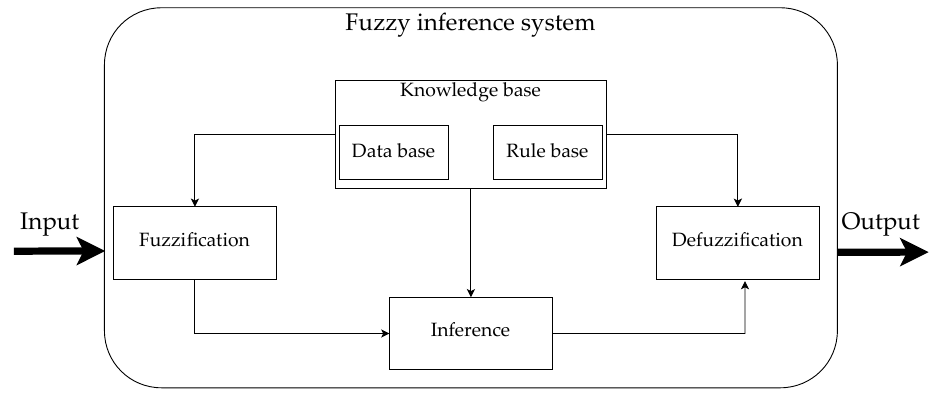
Figure A2. General layout of FIS.